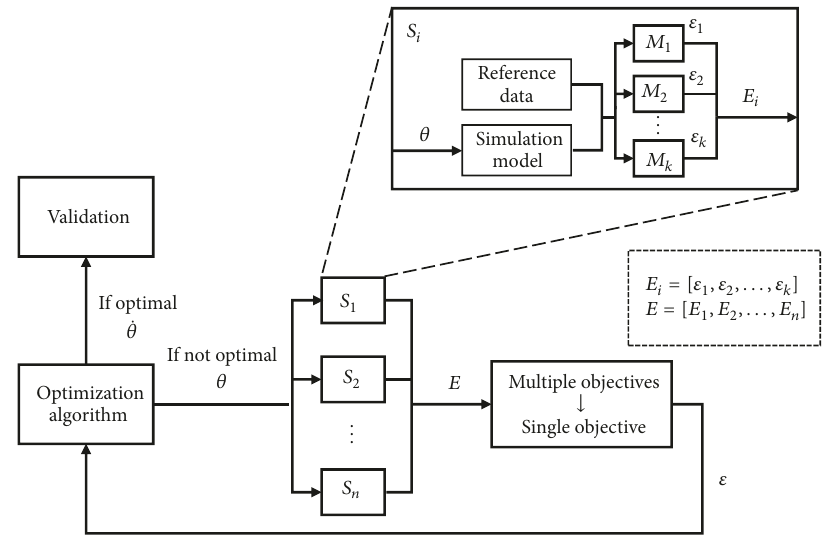
Figure 3: Overview of the multiple-objective methodology where 𝑆 1 to 𝑆 𝑛 are the used scenarios, 𝑀 1 to 𝑀 𝑘 the used metrics, 𝜖 1 to 𝜖 𝑘 the individual errors, and 𝐸 𝑖 the combined error for scenario 𝑖 , 𝜖 the combined error and 𝜃 the parameter